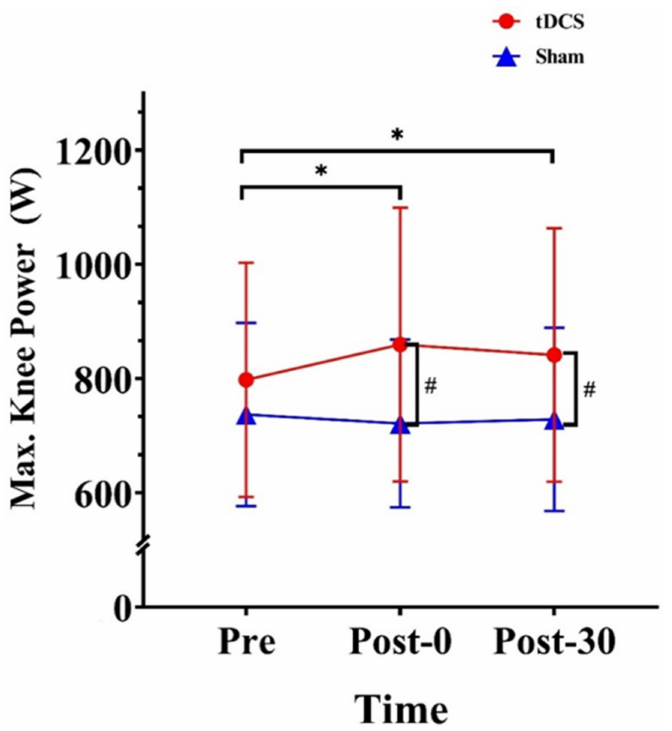
Figure 8. Effects of tDCS on maximum knee power in CMJs. * indicates a significant difference between times. # indicates a significant difference between conditions. Max., maximum. Pre: pre-stimulation, Post-0: post-0 min, Post-30: post-30